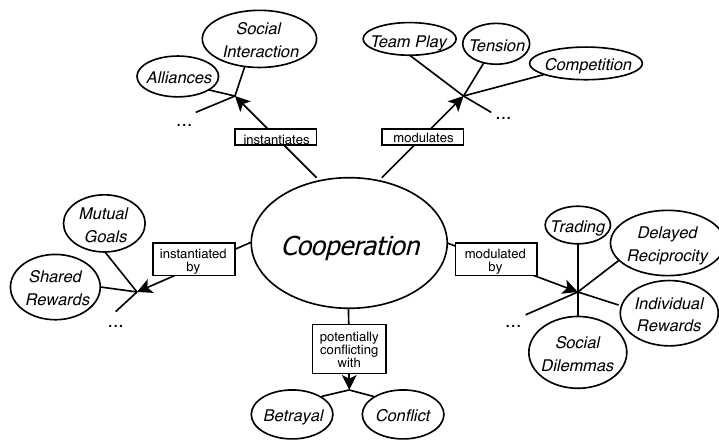
Figure 4. A template of a game design pattern.